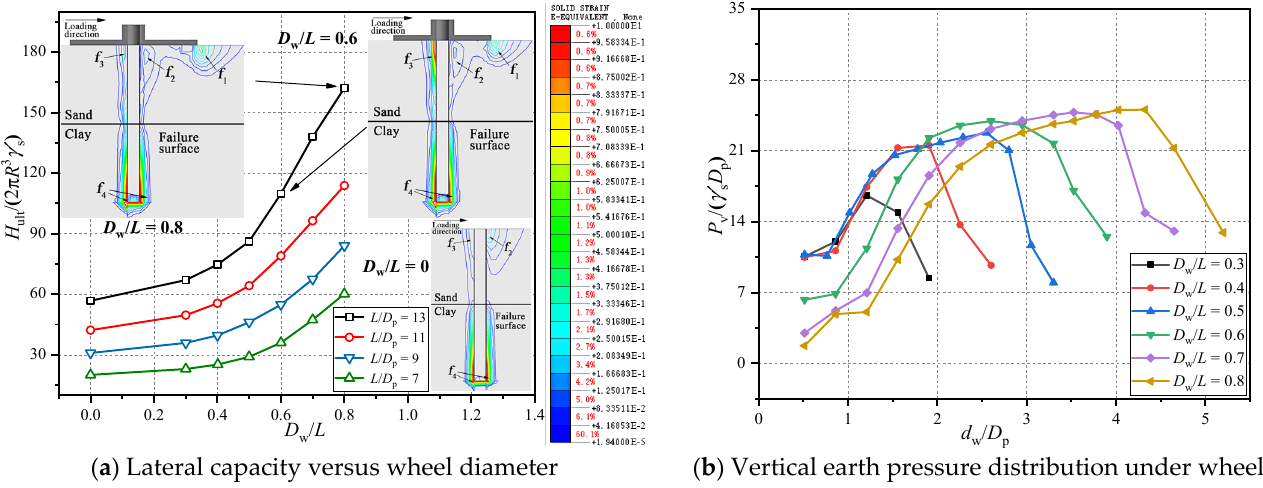
Figure 4. Effect of wheel diameter on the lateral capacity and the failure mechanism.